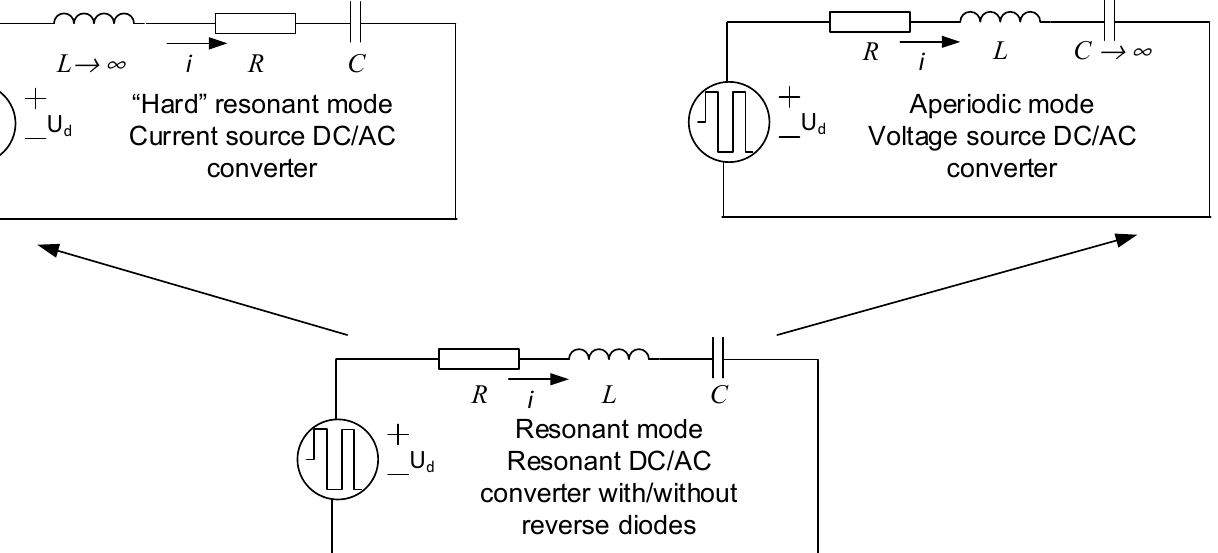
Figure 2. Generalized equivalent circuits of the three main types of DC/AC converters and the transition between them.